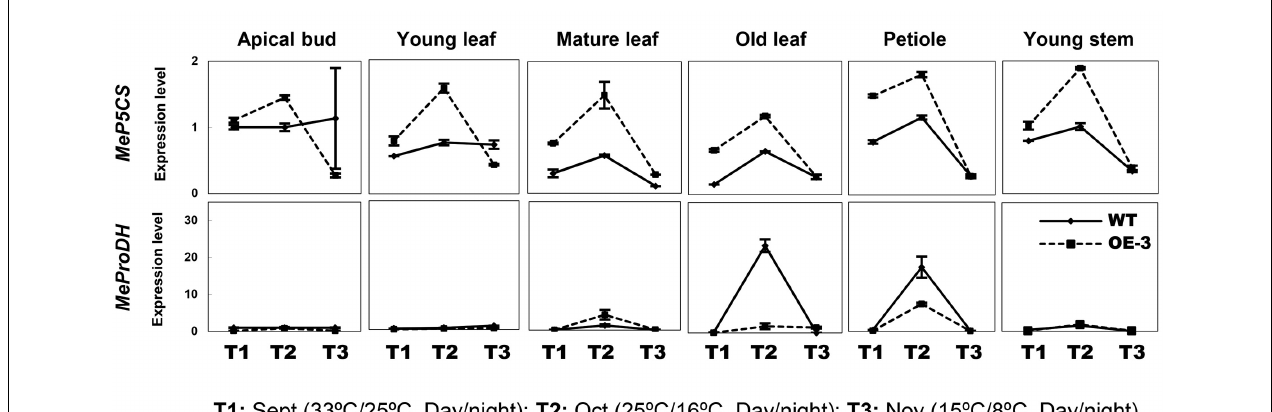
FIGURE 6 | Expression patterns of MeP5CS and MeProDH in cassava under the seasonal temperature changes. Six different tissues of WT and the OE-3 transgenic plants were used, including apical bud, young leaf, mature leaf, old leaf, petiole, and young